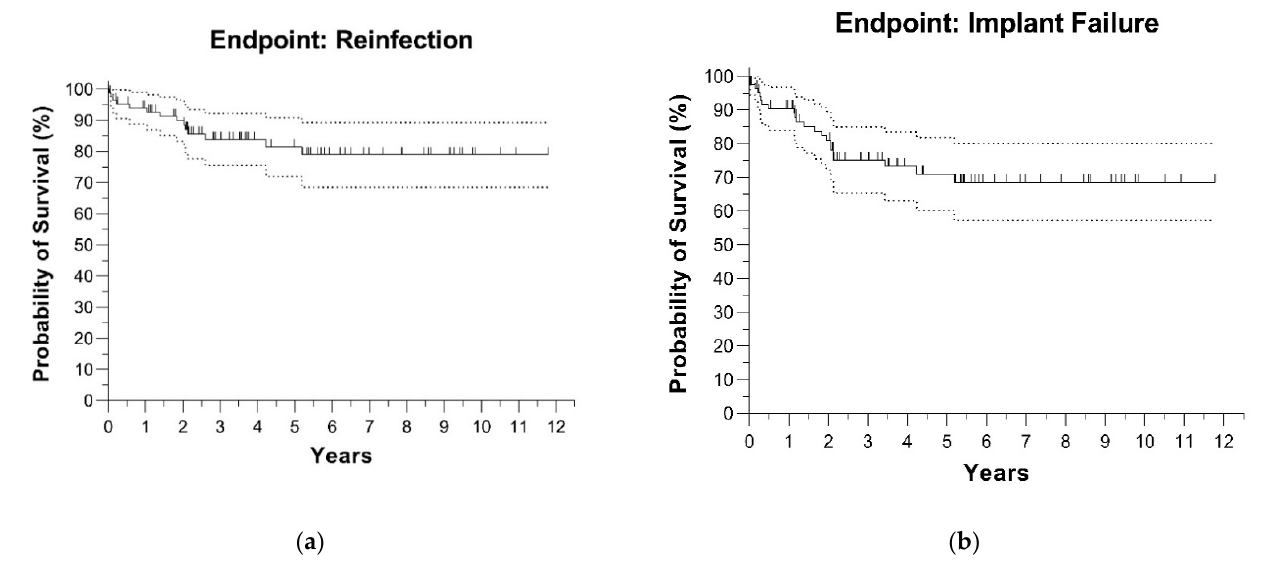
Figure 3. Kaplan–Meier curves with ( a ) reinfection and ( b ) implant failure for any reason as events of interest. All 87 patients with PJI according to MSIS are included. The dotted lines are the confidence intervals per x-value, the vertical stripes are censored events.